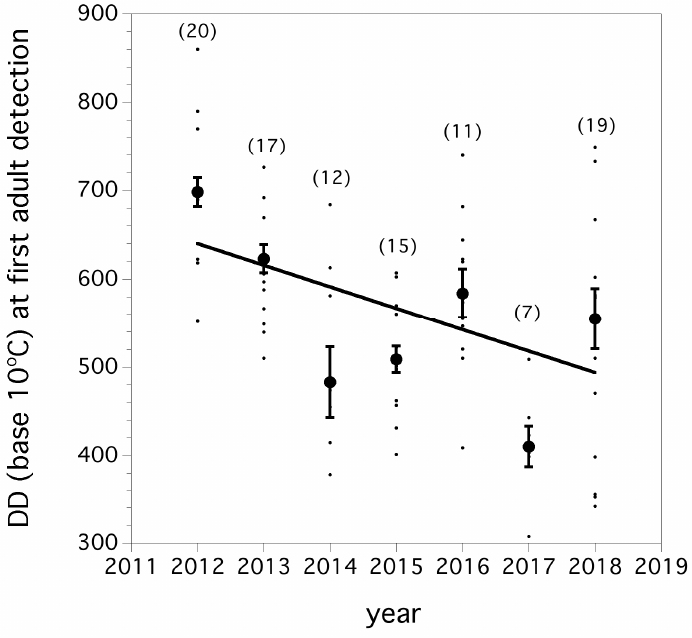
Figure 3. Degree day (base 10 °C) at first fly detection in a trap. Small filled circles are individual field captures and large filled circles are annual means (error bars are standard errors). Parentheses above each year are the number of fields where degree-day information was available ( n = 101). Solid line is linear regression fit.